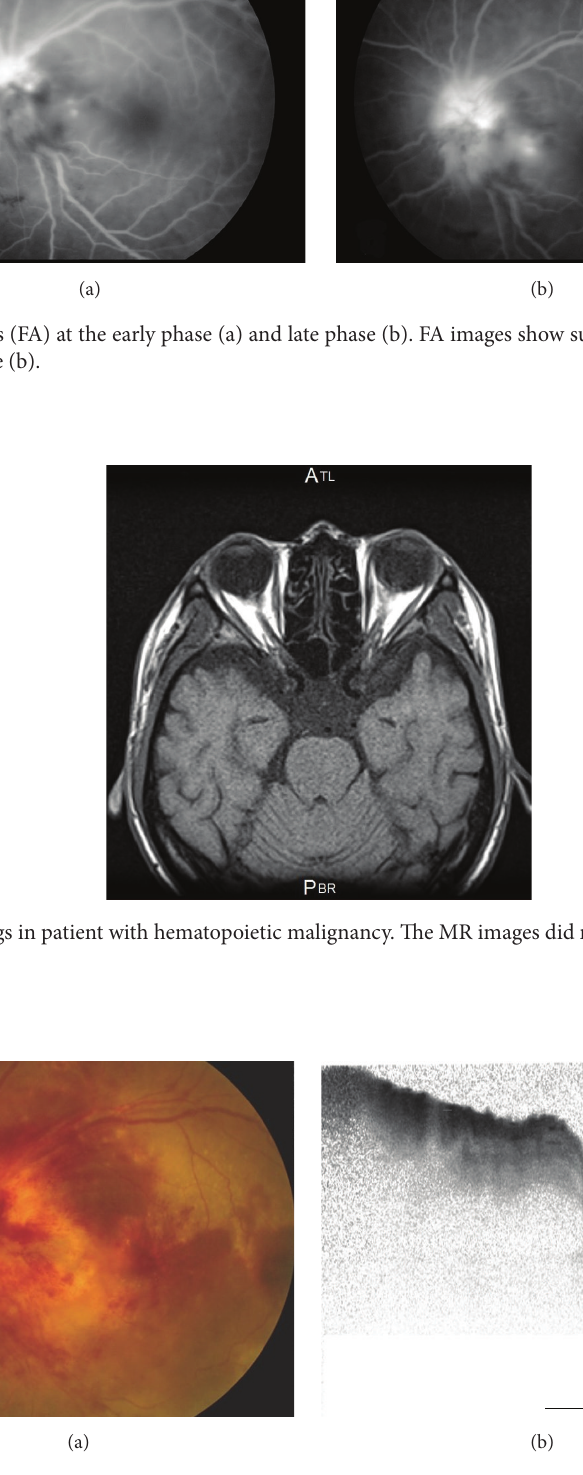
Figure 4: Fundus photograph and OCT image 2 years after the diagnosis of hematopoietic cancer and 2 weeks before death. Optic nerve findings are more